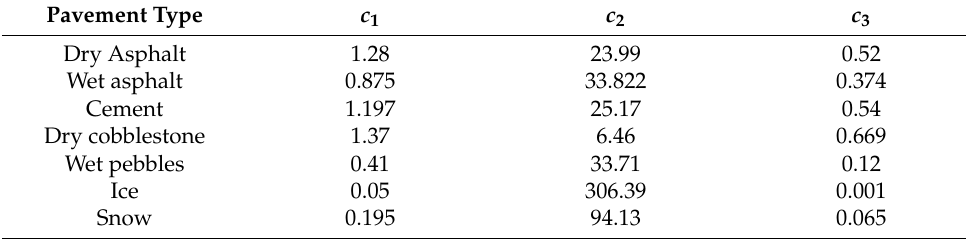
Table 1. Simulation